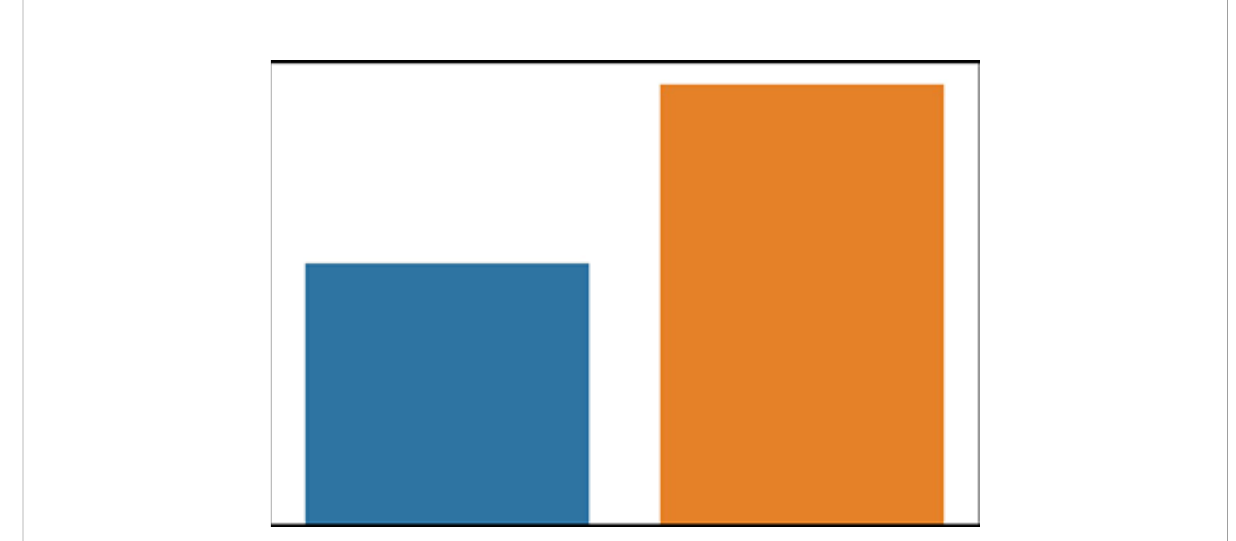
FIGURE 1 Distribution of benign and malignant cases in the dataset (M=malignant,